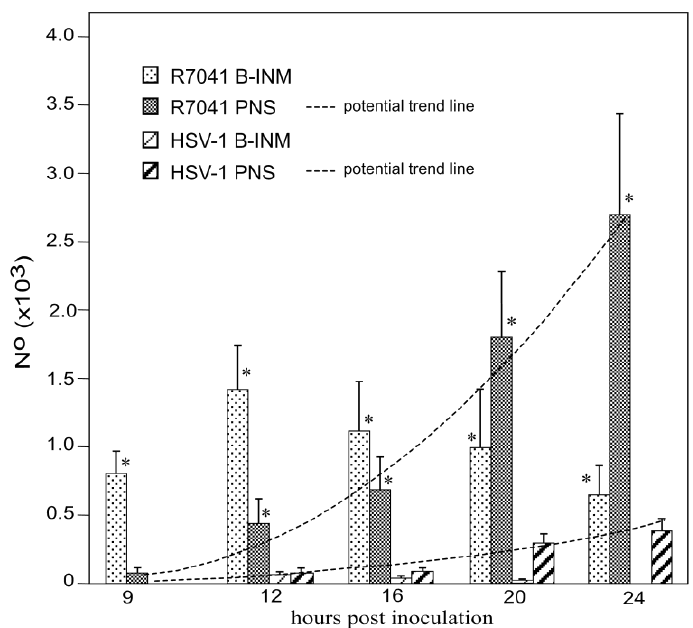
Figure 4. Mean and standard deviation of R7041(∆U S 3) and wt HSV-1 capsids budding at the INM, and of virions within the PNS calculated per mean nuclear volume. Budding of R7041(∆U S 3) capsids peaked at 12 hpi whereas the number of R7041(∆U S 3) and